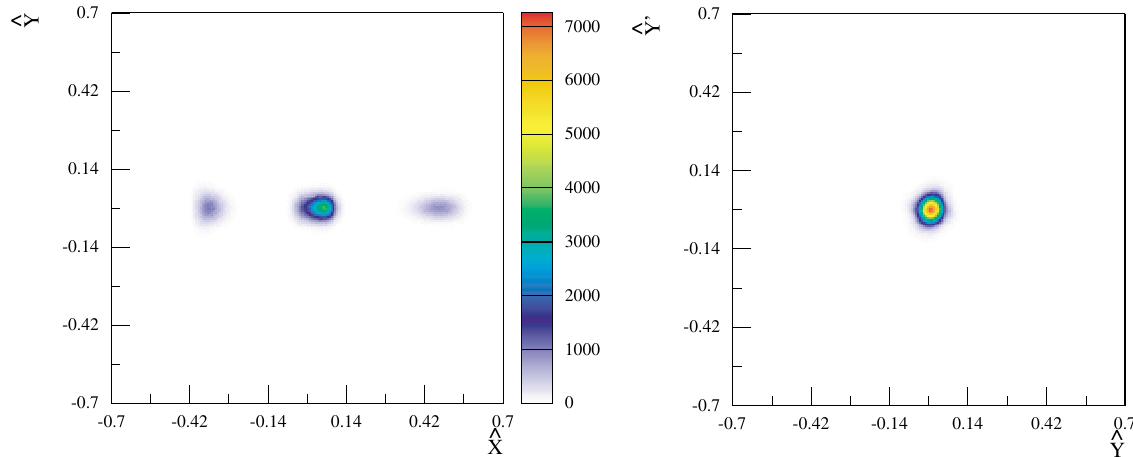
FIG. 7. (Color) Phase space projections: physical space (cid:3) ^ XX; ^ YY (cid:4) (left panel) and vertical phase space (cid:3) ^ YY; ^ YY 0 (cid:4) (right panel) of the capture process with four islands as computed using the 4D map (1) with (cid:14) (cid:1) (cid:6) 1 : 5 and (cid:13) (cid:1) 0 : 5 . The vertical tune (cid:26)